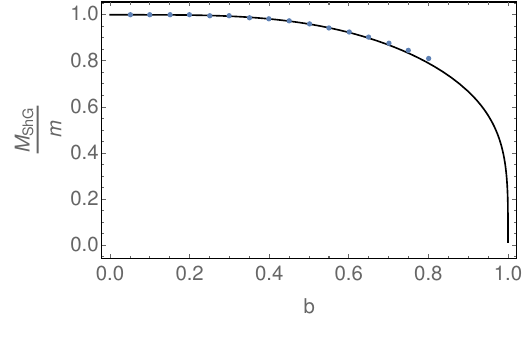
(a) Measured versus theoretical masses, nor- malized with respect to m .